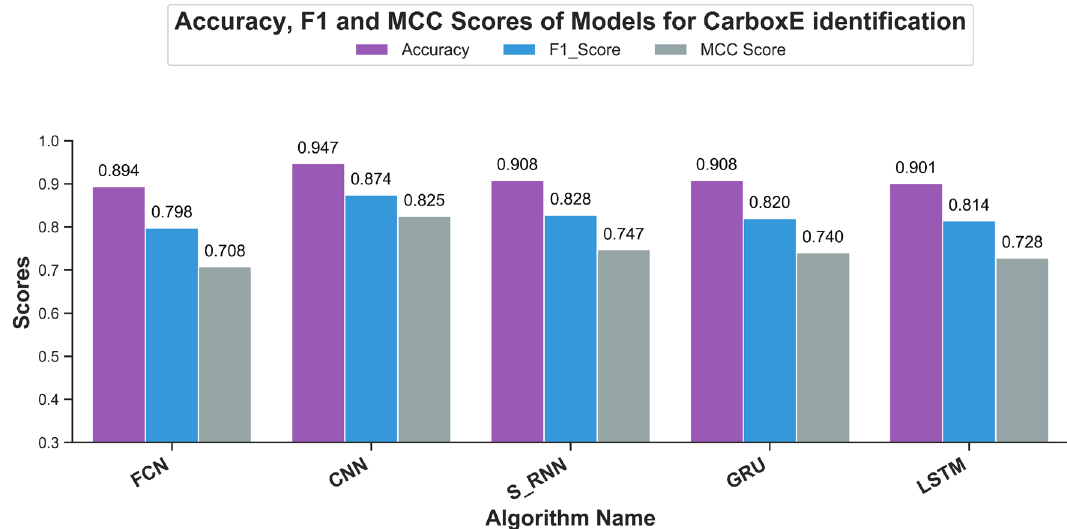
Figure 4. Accuracy, F1-measure, and MCC scores of DNN-based CarboxE site prediction